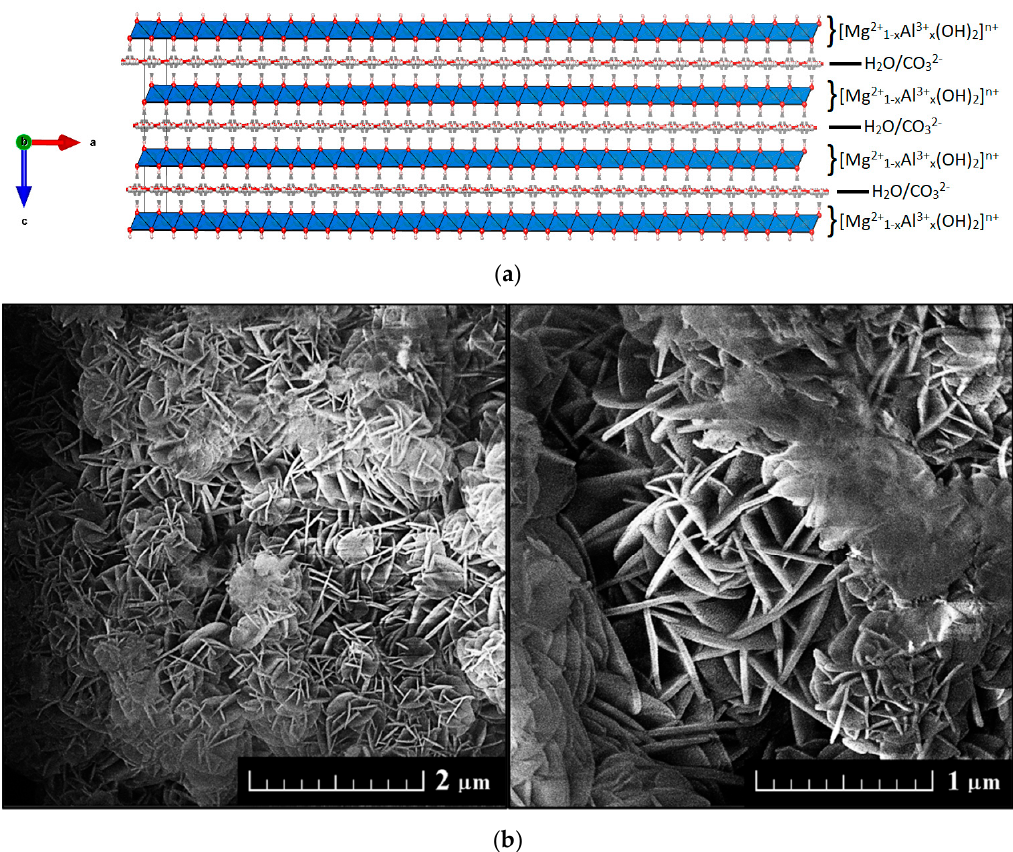
Figure 1. Typical structure of hydrotalcites ( a ) and SEM images of the hydrotalcyte sample with typical morphology ( b ).